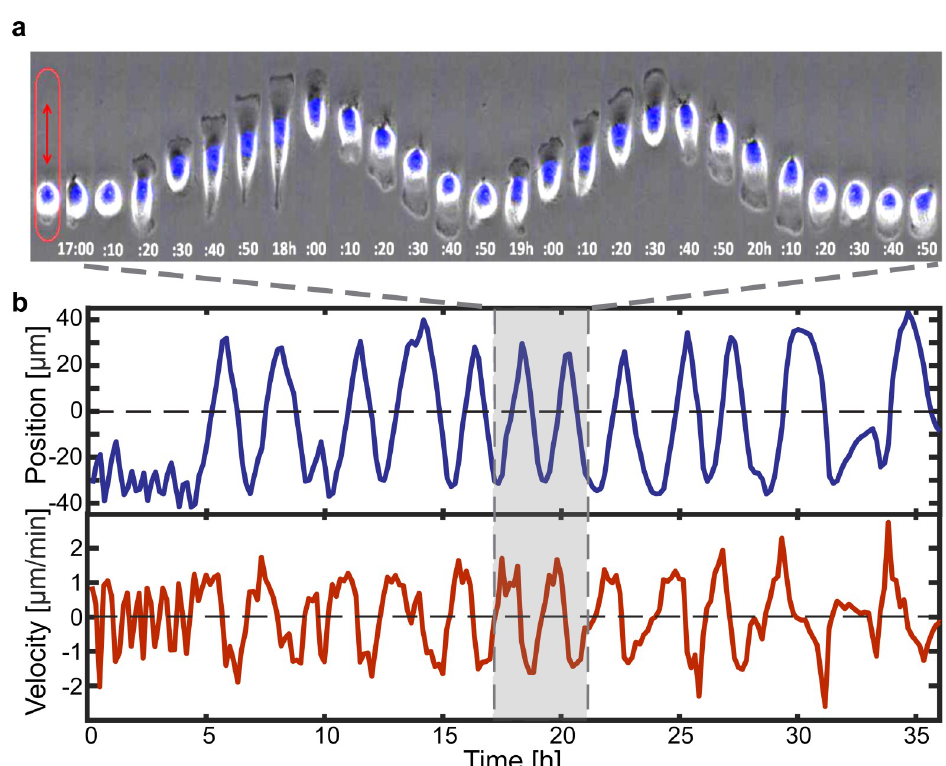
Fig 1. Cell migration on microlanes. ( a ) Time sequence of a cell (MDA-MB-231) migrating on a stripe-shaped micropattern (Stripe length L = 120 μ m, width W = 20 μ m, 10 min time intervals). Images are taken in phase contrast and with fluorescence microscopy. The nucleus is labeled with Hoechst 3334 as indicated in blue. ( b ) Trajectory of the cell nucleus tracked over the course of 36 h showing quasi-periodic alternations between directed migration and repolarization. Additional exemplary trajectories of cells, which represent the broad distribution of frequencies, can be found in S2 Fig.